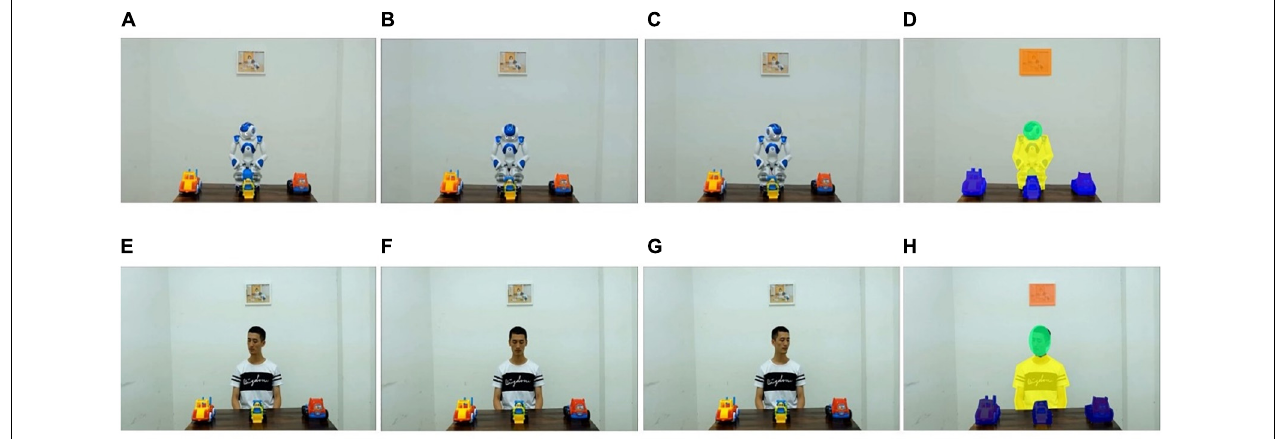
FIGURE 1 | Stills from the stimuli in (A–C) the robot condition, and (E–G) the human condition. (D,H) Indicate the areas of interest: the green area is the agent’s face, the yellow area is the agent’s body, the blue areas are the three objects (target and non-targets), the orange area is the picture frame (distractor), and the rest of the screen is the background. Written informed consent was obtained from the individual for the publication of this